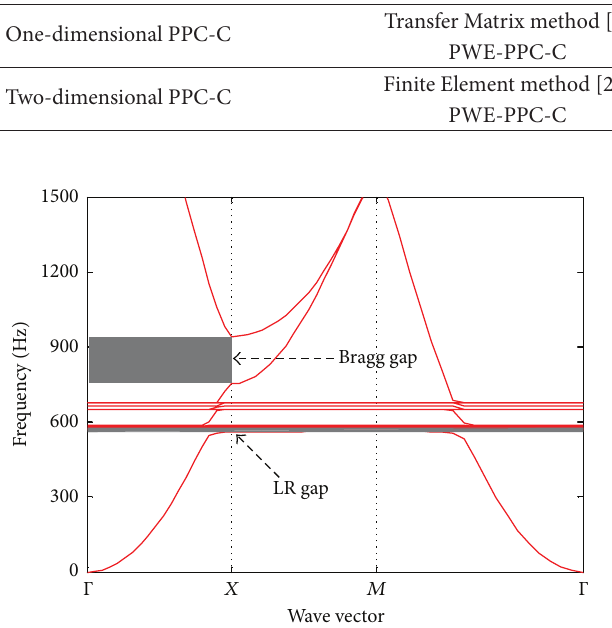
Figure 5: Band structure of the two-dimensional PPC-C of orthog- onal lattice, where 𝑅 𝐿 = 50 Ω and 𝐿 = 0.25